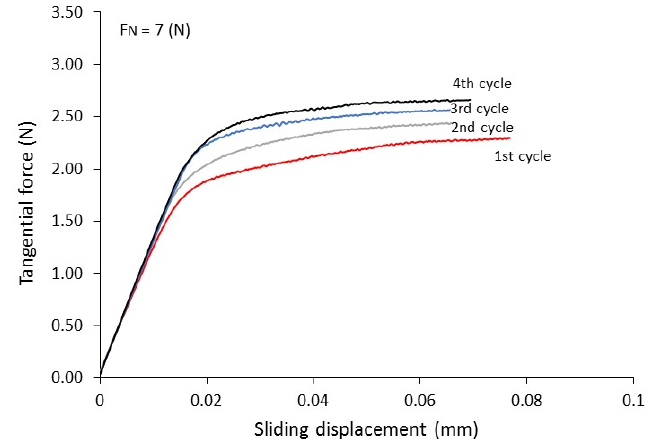
Figure 15. Tangential force–displacement plots at the contacts of LBS grains indicating the effect of the shearing cycle at a normal force of 7 N. Energies 2017 , 10 , 370